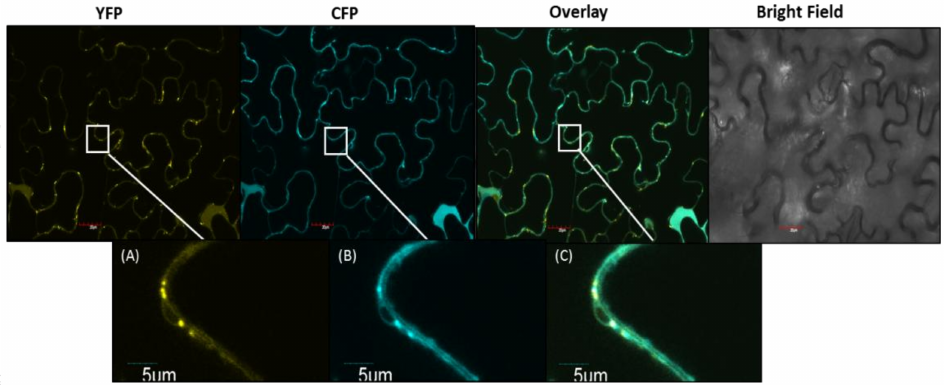
Figure 5. Subcellular localization of PCS2. ( a ) YFP-tagged PCS2; ( b ) CFP-tagged mitochondrial marker (Mt-CFP); ( c ) Co-localization of PCS2 with Mt-CFP. YFP: Yellow fluorescent protein; CFP: Cyan fluorescent